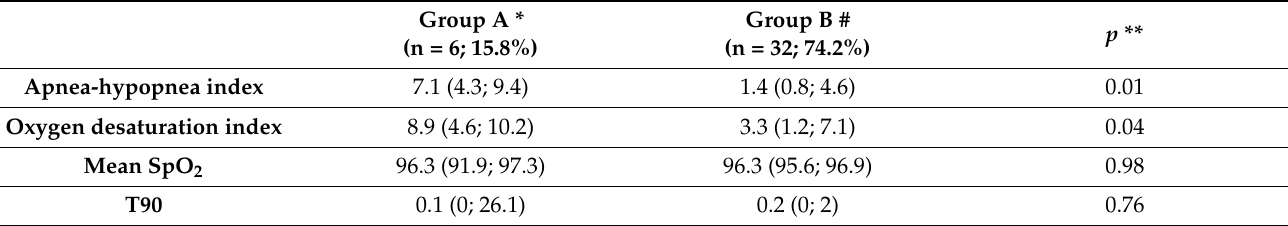
Table 7. Comparison of polygraphy parameters between group A * and group B # patients with Down